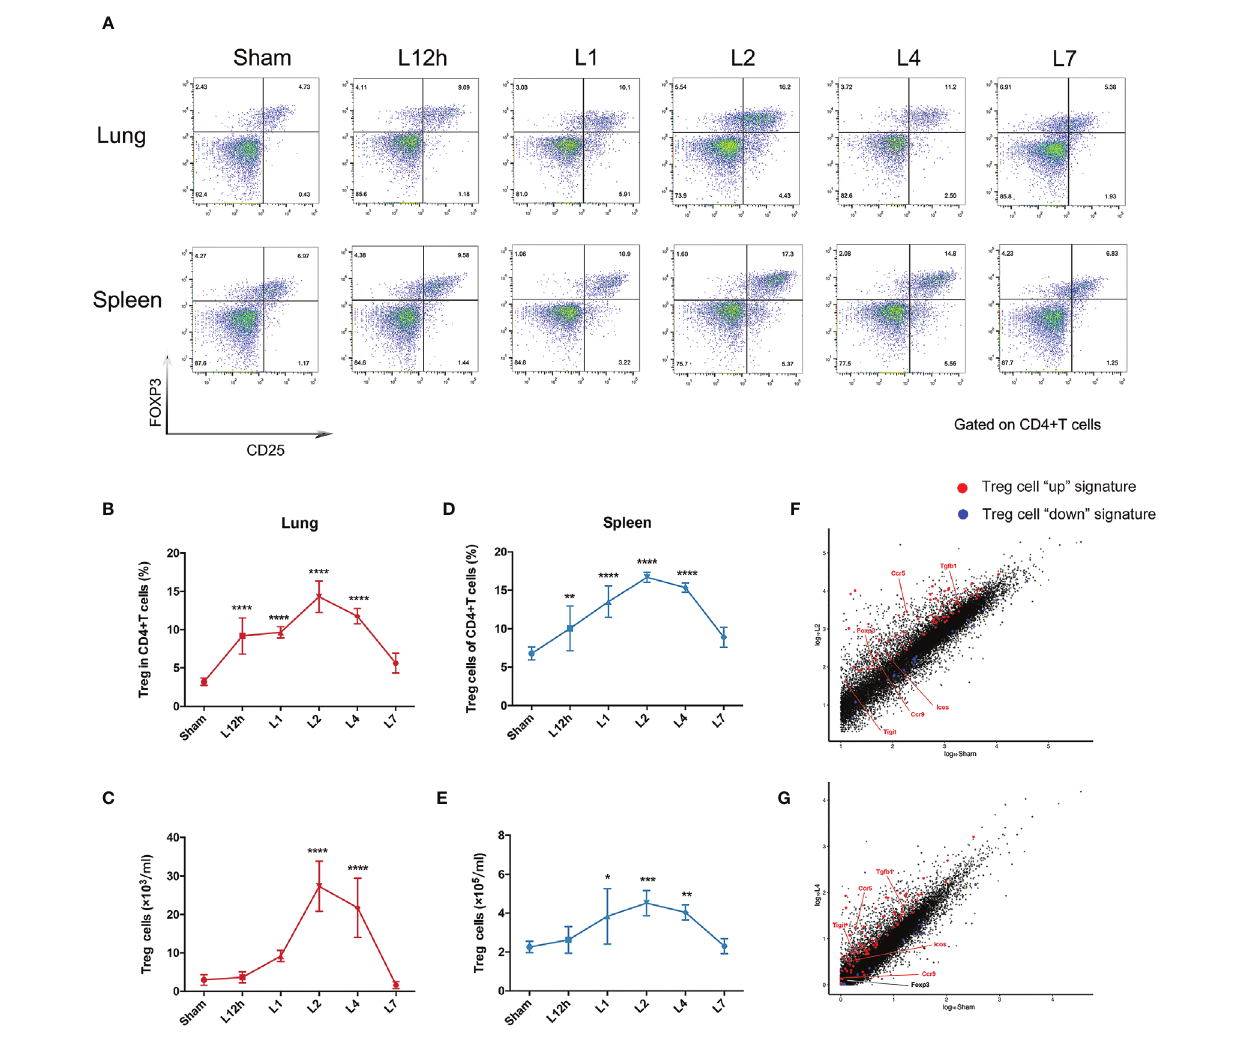
FIGURE 2 | Treg cells accumulate in LPS-induced acute respiratory distress syndrome. BALB/c mice were intratracheally injected with LPS. The experiment was repeated twice. (A) Cyto fl uorometric dot plots of Tregs within days after injury. Numbers depict the fraction of CD4+ T cells within the designated gate. (B) Summary data for the fraction of Treg cells in the lungs depicted in (A) . (C) Summary data for the number of Treg cells in the lungs depicted in (A) . (D) Summary data for the fraction of Tregs in the spleen depicted in (A) . (E) Summary data for the number of Treg cells in the spleen depicted in (A) . (F, G) RNA-seq analysis. Normalized expression values for Treg cells (F) on day 2 and (G) on day 4 in the lung after LPS injury. Treg cell “ up ” (red) and “ down ” (blue) signature transcripts overlain, with some key Treg cell up genes highlighted. For all panels: mean ± S.D. *p ≤ 0.05; **p ≤ 0.01; ***p ≤ 0.001; and ****p ≤ 0.0001 for one-way analysis of variance with the Bonferroni post hoc test for multiple t-tests. A value of p < 0.05 was considered statistically signi fi cant. n = 6 mice per